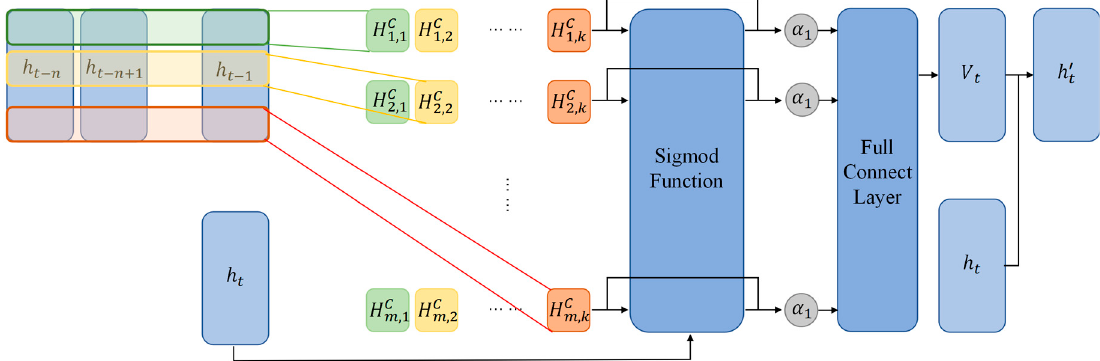
Figure 5. Attention mechanism of sequential